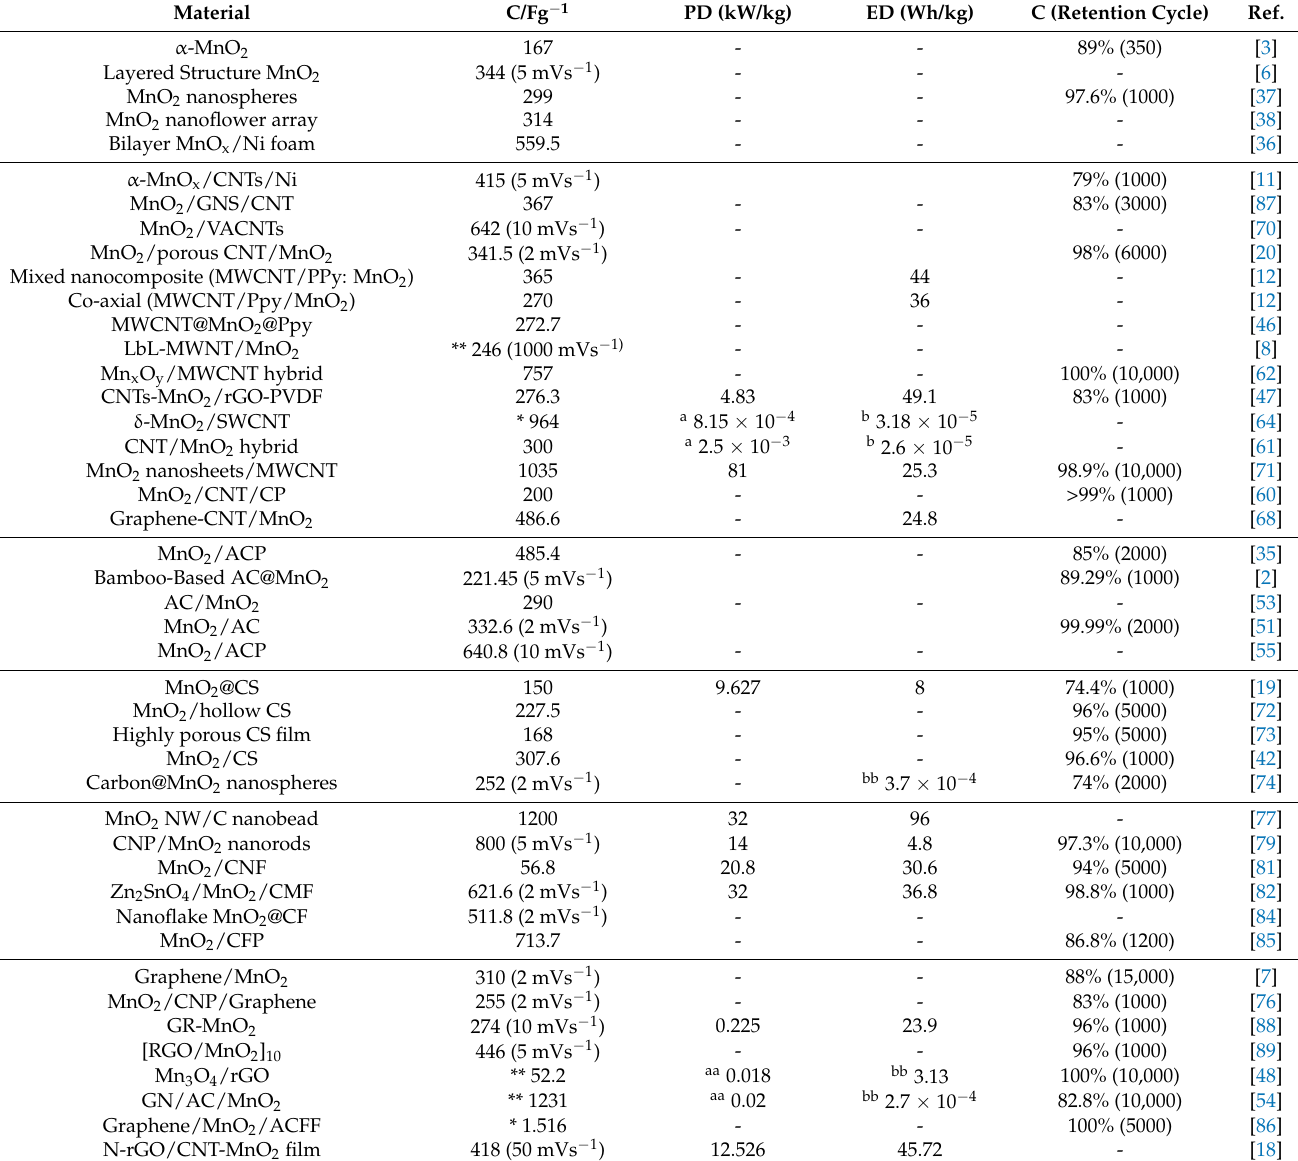
Table 1. Specific capacitance comparison of some of carbon-based/MnO x